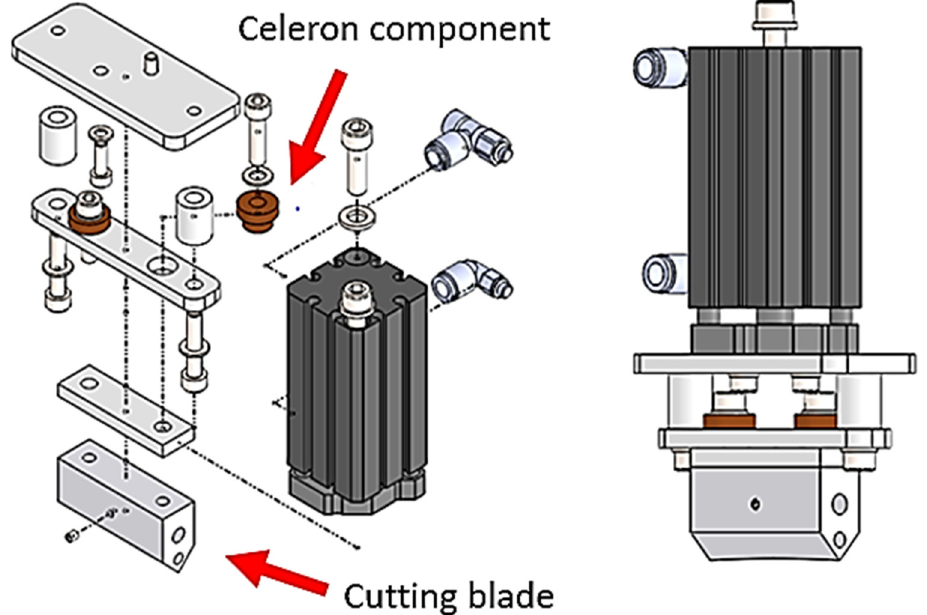
Figure 23. Cutting sub-assembly’s exploded and assembled view.